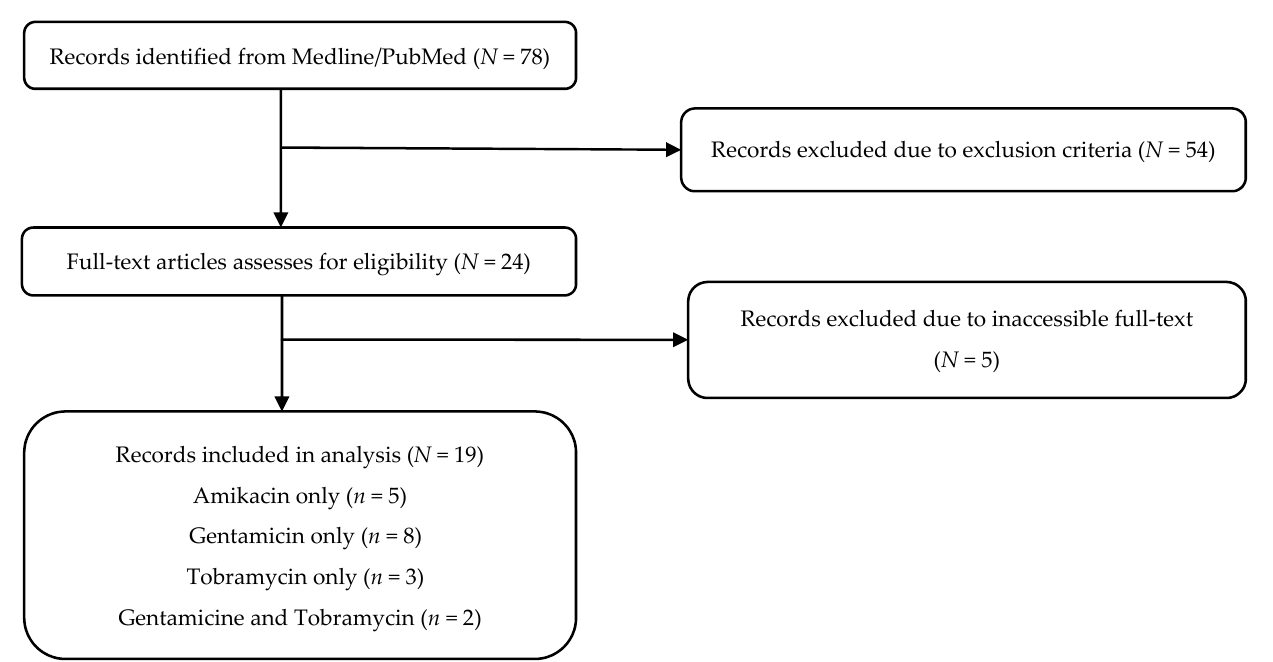
Figure 1. PRISMA chart.